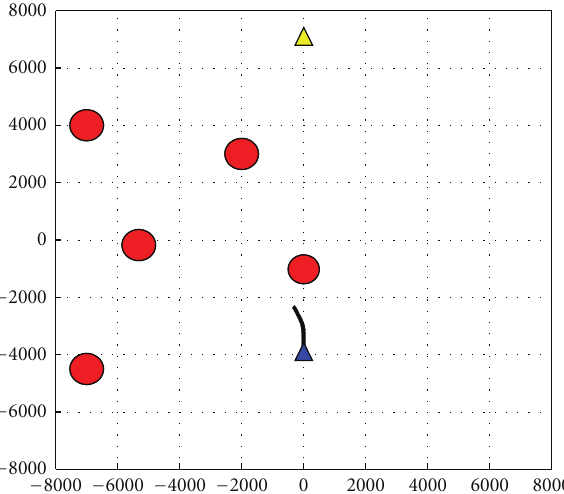
Figure 3: Planner simulation environment.